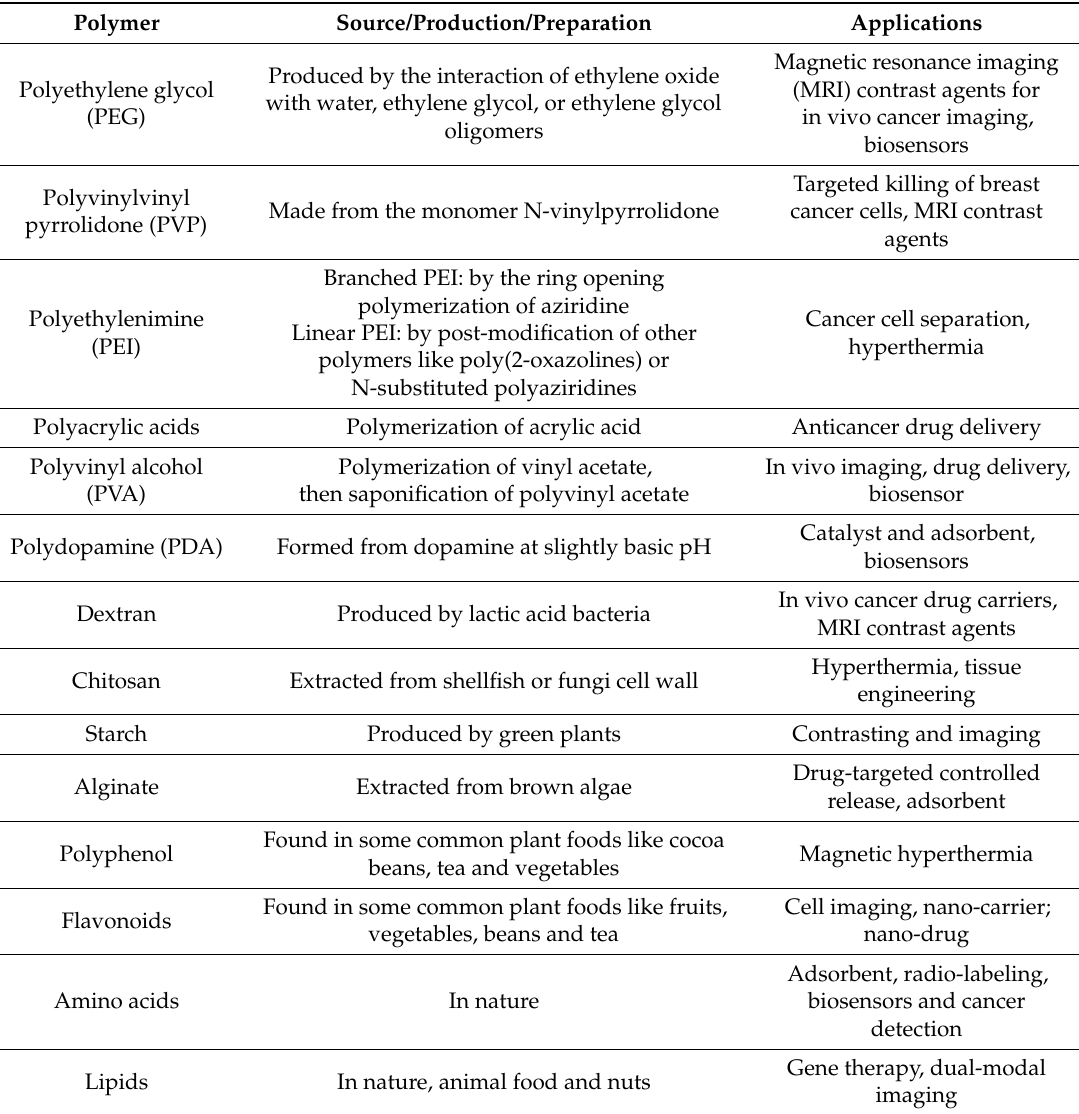
Table 3. Polymers used for coating IONPs and their